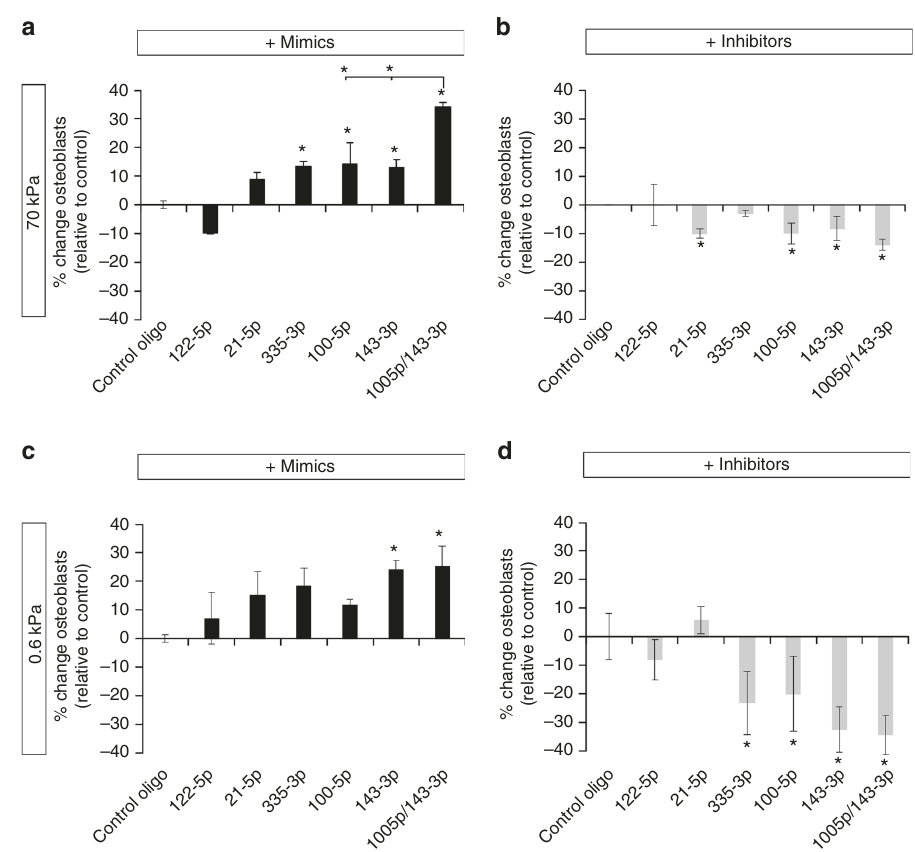
Fig. 3 Modulation of miRNA activity can modulate the hMSC differentiation bias in response to substrate stiffness. Differentiation bias of hMSCs treated with a miRNA mimics or b miRNA inhibitors and cultured on 70 kPa gels and c treated with miRNA mimics or d miRNA inhibitors and cultured on 0.6 kPa gels. Data is shown as mean ± SD of the change in proportion of osteoblasts (see Supplementary Fig. 4 for additional donors). Samples were analysed by one-way ANOVA with Tukey post hoc testing. Statistically different samples are denoted by